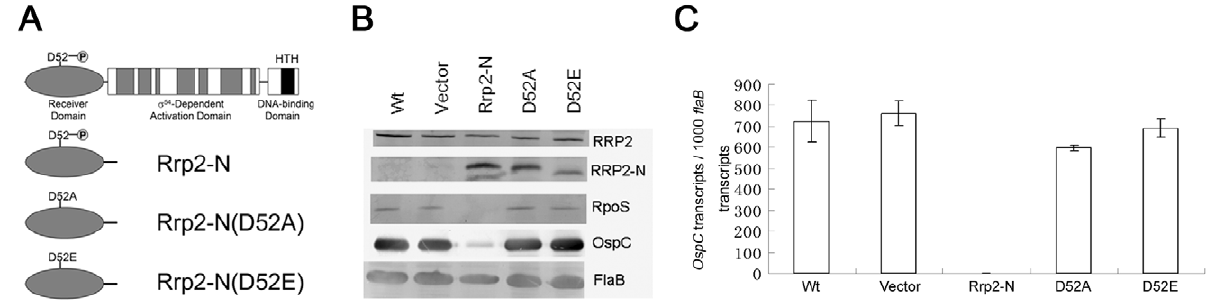
Figure 5. Influence of overexpression of wild-type or mutated version of the Rrp2 N-terminal receiver domain on Rrp2 activation. ( A ) Schematic diagram of predicted Rrp2 domain structure and various versions of overexpressed N-terminal receiver domains. D52 is the putative phosphorylation site. ( B ) Immunoblot of wild-type strain (lane 1), the strain carrying the shuttle vector only (lane 2), the strain with overexpression of Rrp2-N (lane 3), the strain with overexpression of Rrp2-N(D52A) (lane 4), and the strain with overexpression of Rrp2-N(D52E) (lane 5). Cultures were grown to late logarithmic phase at 35 u C. Pooled antibodies/antisera against Rrp2, FlaB, and OspC were used. Bands corresponding to each protein were labeled on the right. ( C ) qRT-PCR analysis of ospC expression in various strains shown in ( B ). Levels of ospC transcript were normalized per 1000 copies of flaB in each sample.